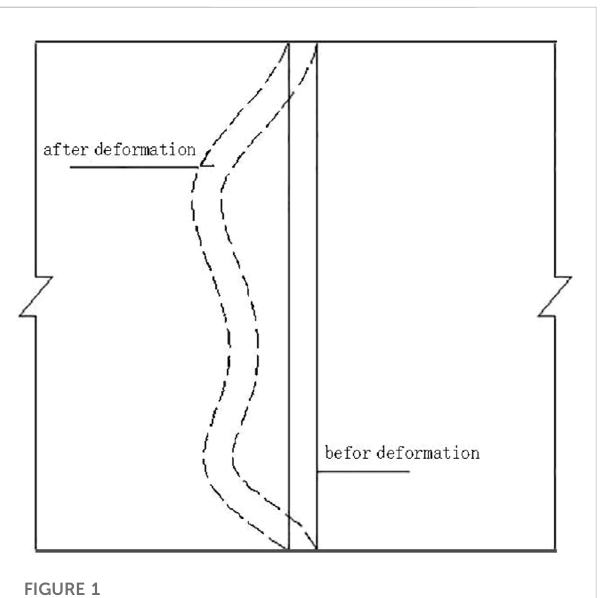
FIGURE 2 Fracture failure of steel nodes (Schematic